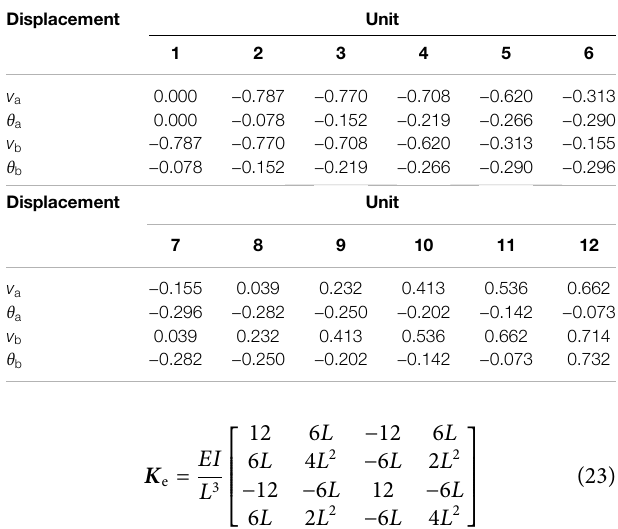
TABLE 2 | Node displacement of simply supported beam